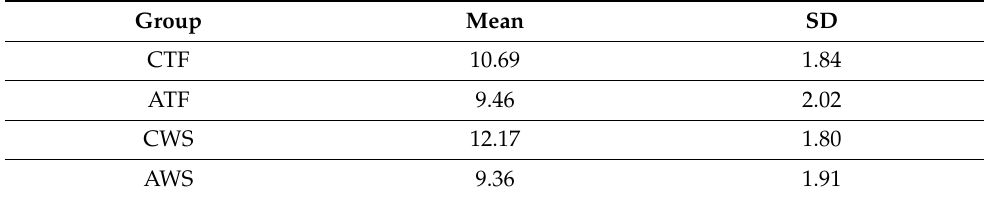
Table 4. Mean number of phrases and SD per